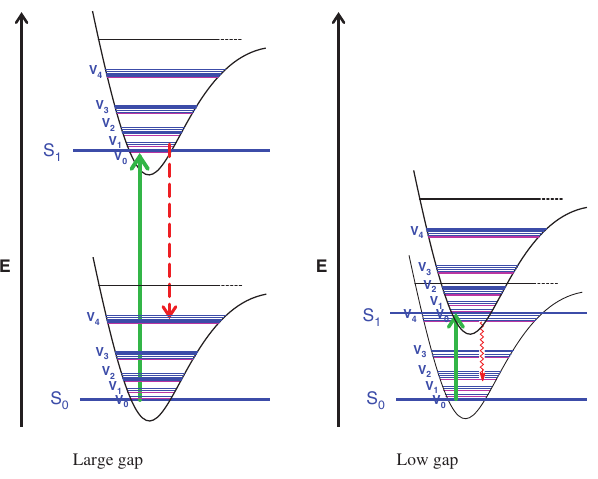
Figure 3: Illustration of the low energy gap law. Longer wavelength of emission comes with stronger overlap that weakens the emission. S and S are the energy levels of the ground 0 1 and excited states, respectively; v indicates vibrationally excited n levels; green arrows indicate absorption; and red arrows indicate radiative (dashed) or non-radiative relaxation